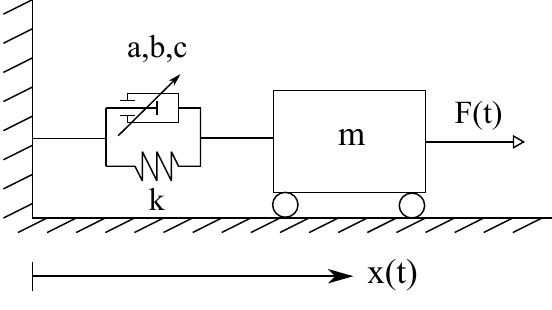
Figure 2. Nonlinear mechanical